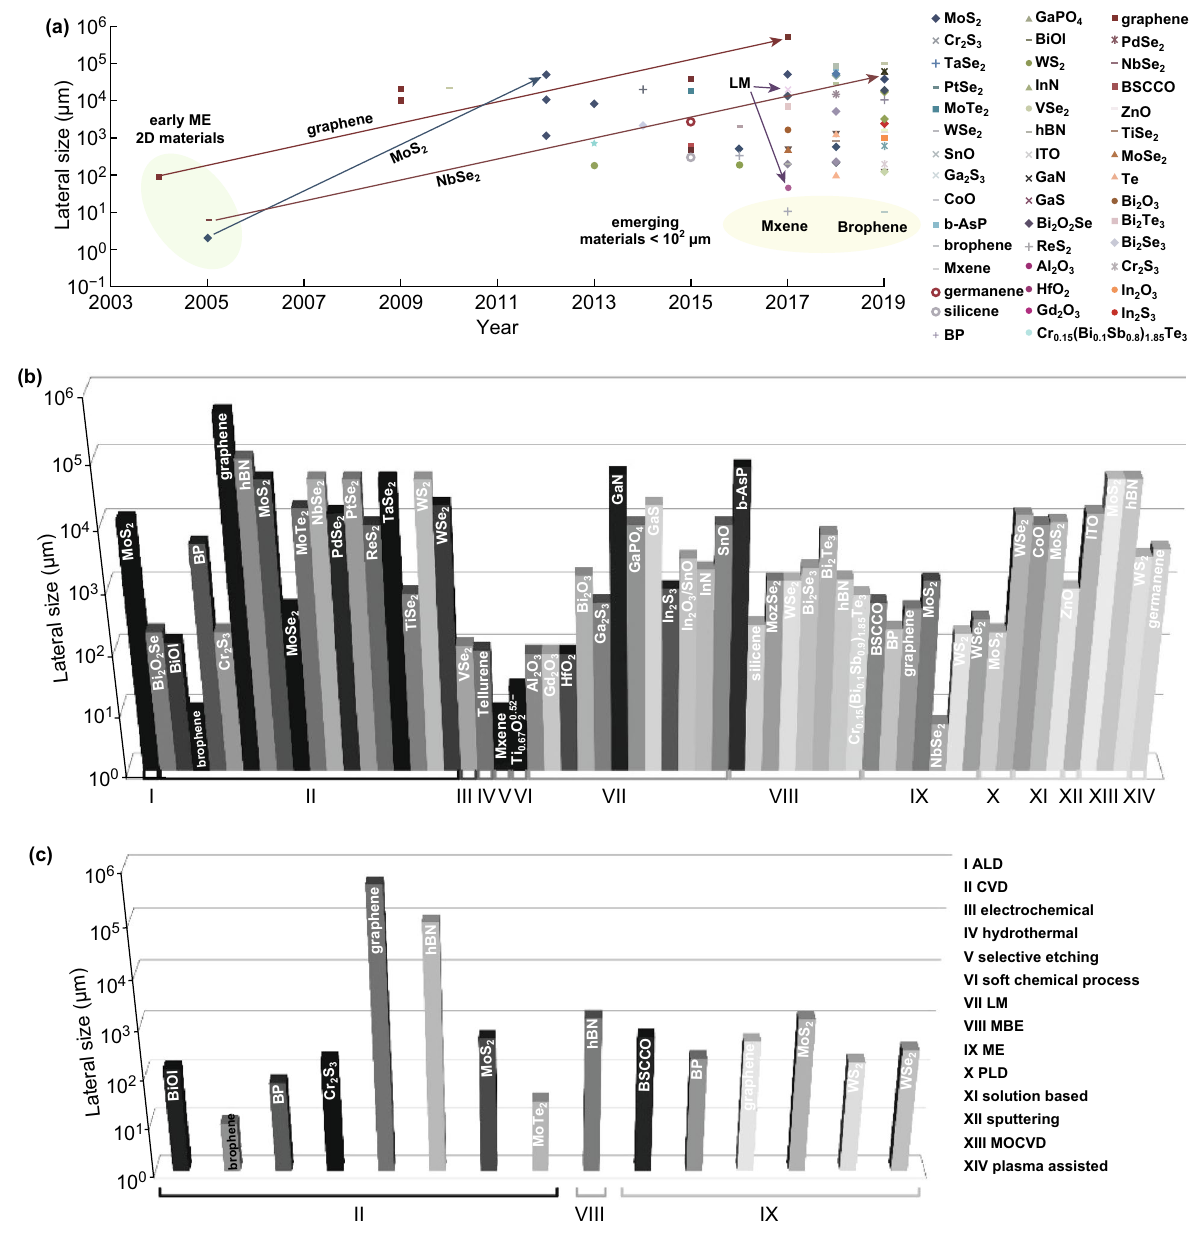
Fig. 1 Lateral dimensions of 2D materials. a Evolution of lateral sizes from ME to CVD synthesis are shown for MoS 2 , NbSe 2 and graphene with arrows. Emerging 2D materials below 100 µm in lateral dimensions is highlighted in yellow. b Lateral dimensions are elucidated for each 2D material derived from different synthesis routes [2, 3, 7, 10–71]. c Record lateral dimensions achieved as a single crystal [3, 11, 17, 20, 21, 23, 24, 38, 41, 46, 57, 58, 66]. (Color figure